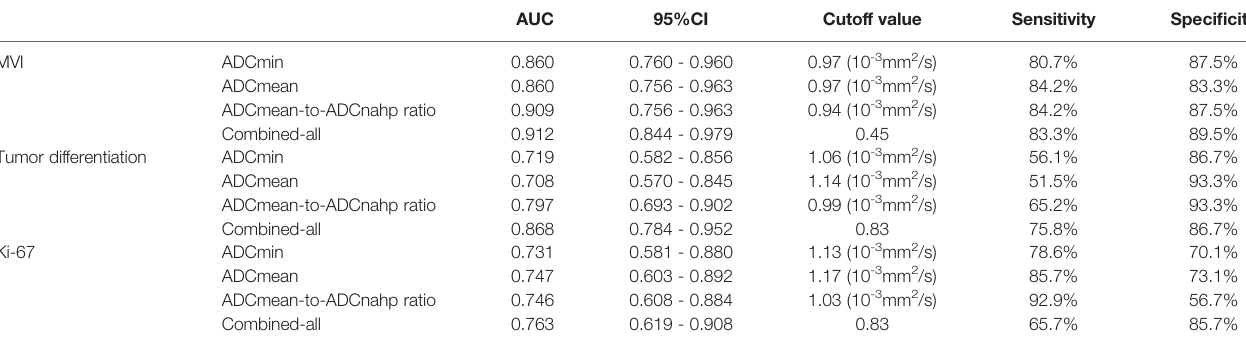
TABLE 3 | ADC value, predictive probability and pathological features of hepatocellular carcinoma.